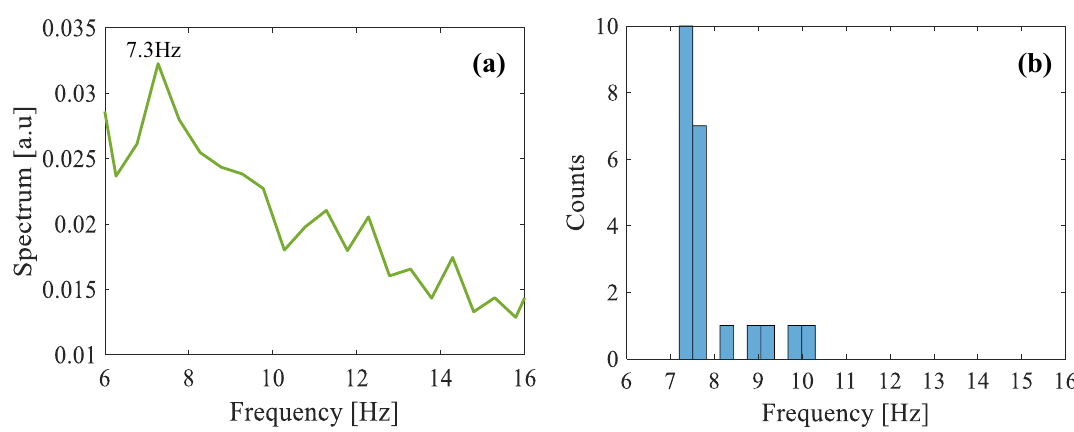
Figure 5. ( a ) The average spectrum of the measurements extracted from the mucosa at the nasal cavity presents a peak in the spectrum around 7.3 Hz and ( b ) a histogram of the motion frequencies extracted from multiple ciliated mucosa